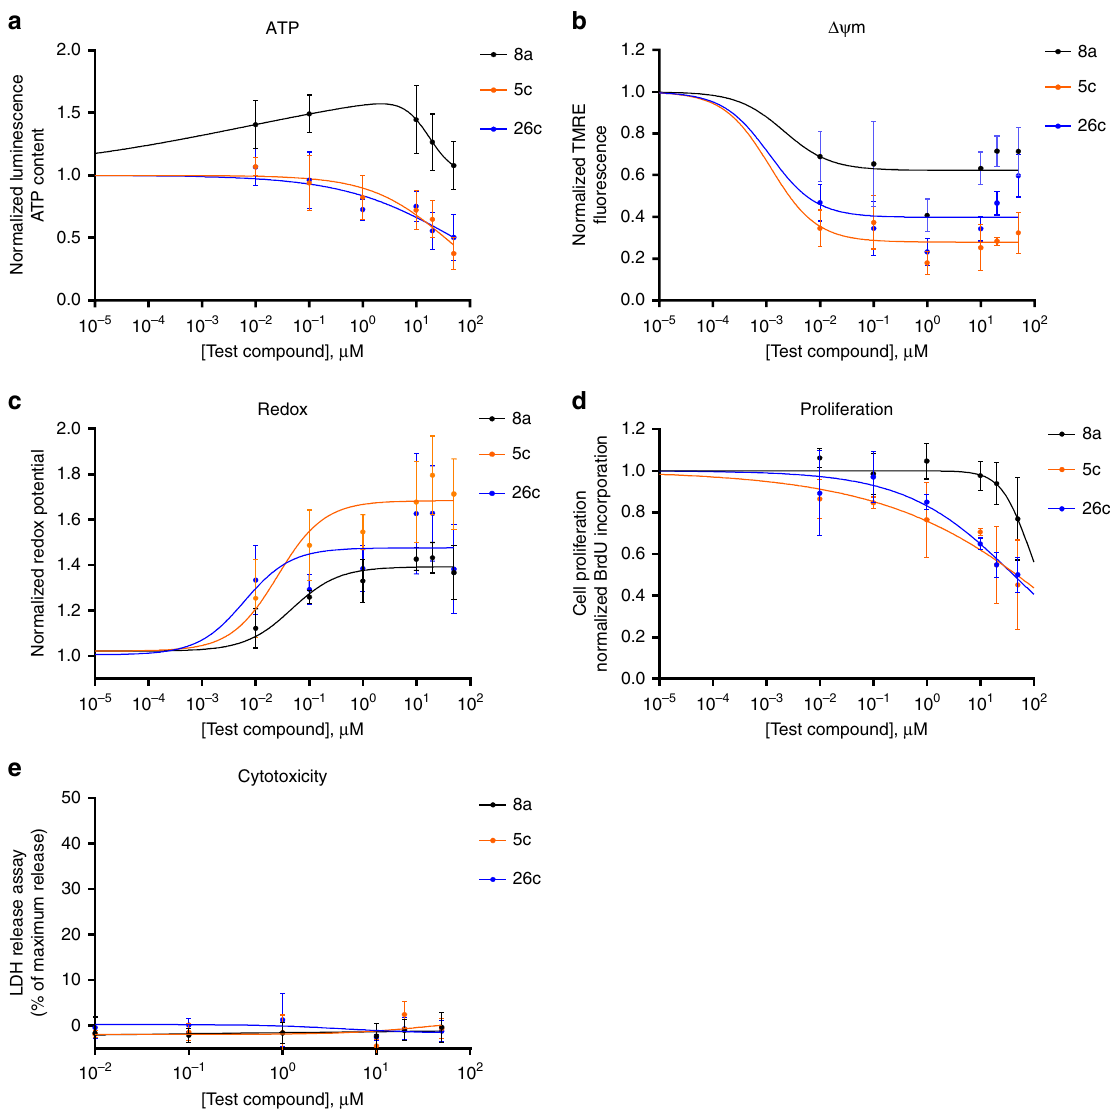
Fig. 9 Screening of a pilot library on cellular functions in Hepa1 – 6. a Effect of compounds 5c and 26c on ATP. b Effect of compounds 5c and 26c on mitochondrial membrane potential. c Effect of compounds 5c and 26c on cellular redox potential. d Effect of compounds 5c and 26c on cellular proliferation. e Cytotoxicity of compounds 5c and 26c . Error bars indicate standard deviation based on three replicated calculations. Signi fi cance was tested using an ANOVA test, with Dunnett ’ s multiple comparison